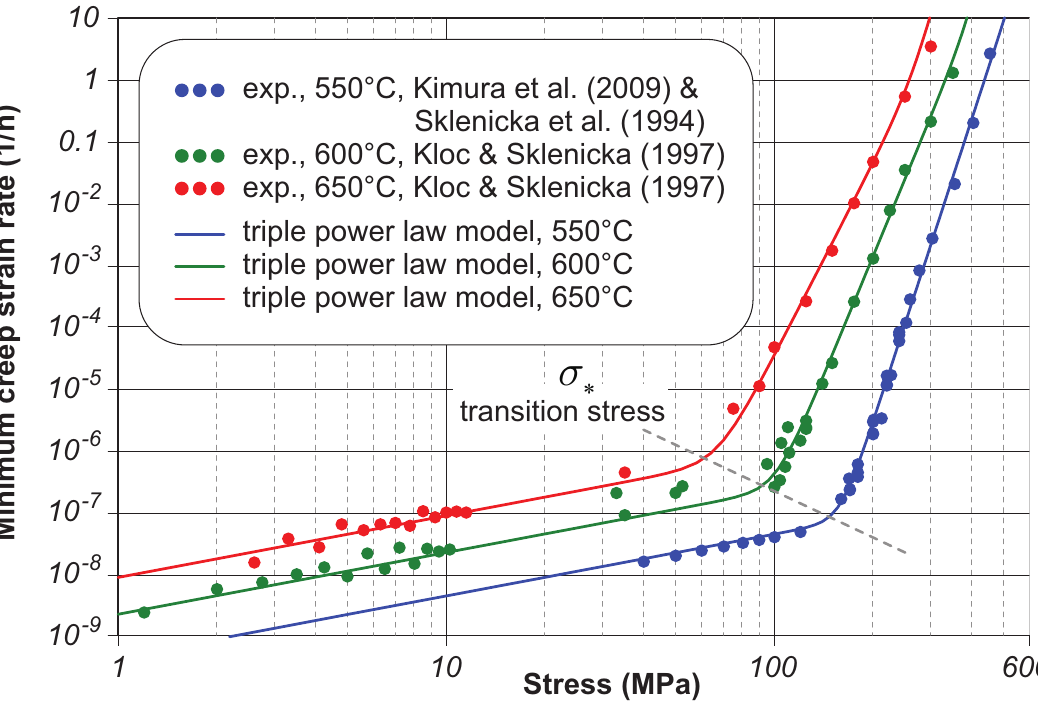
Figure 4: Min. creep rate vs. stress of ASTM P91 steel based on several sets of data [30, 41, 42]